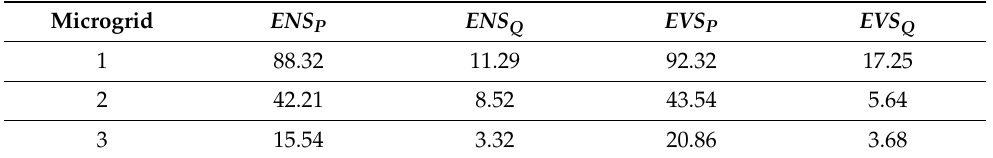
Table 6. Expected unmet energy supply (in terms of MWh and MVArh ) due to lack of active and reactive power.